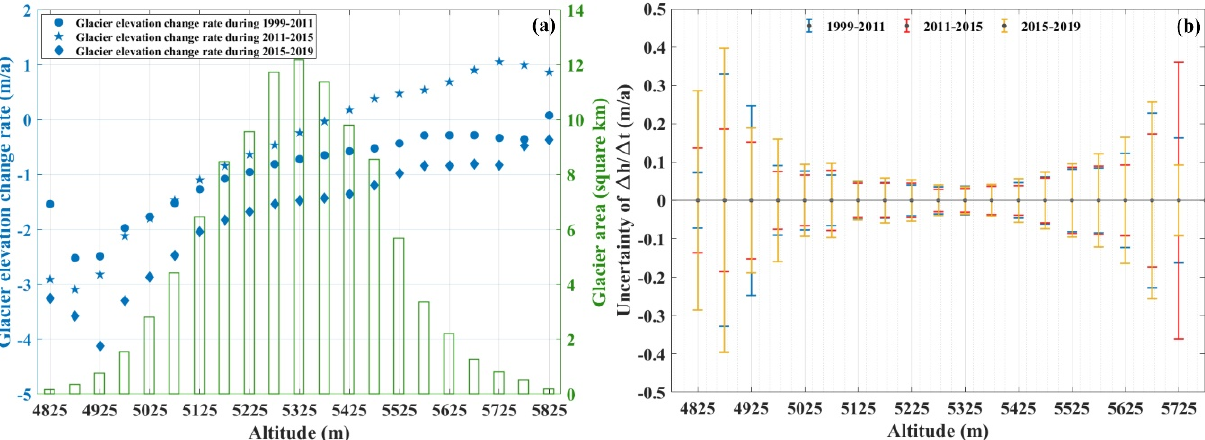
Figure 4. ( a ) Glacier area and average glacier elevation change rate (AGECR) in each 50 m altitude band, and ( b ) the uncertainty of corresponding AGECR. The AGECRs in different observation periods are denoted by different symbols. The uncertainty of AGECR in each altitude band was estimated based on the NMAD of the elevation change rate in stable areas (see Section 4.4). The last two altitude bands have no elevation change rate observations in stable areas, and the uncertainties of the AGECRs in these two altitude bands were assumed to be the same as that of the last but two.